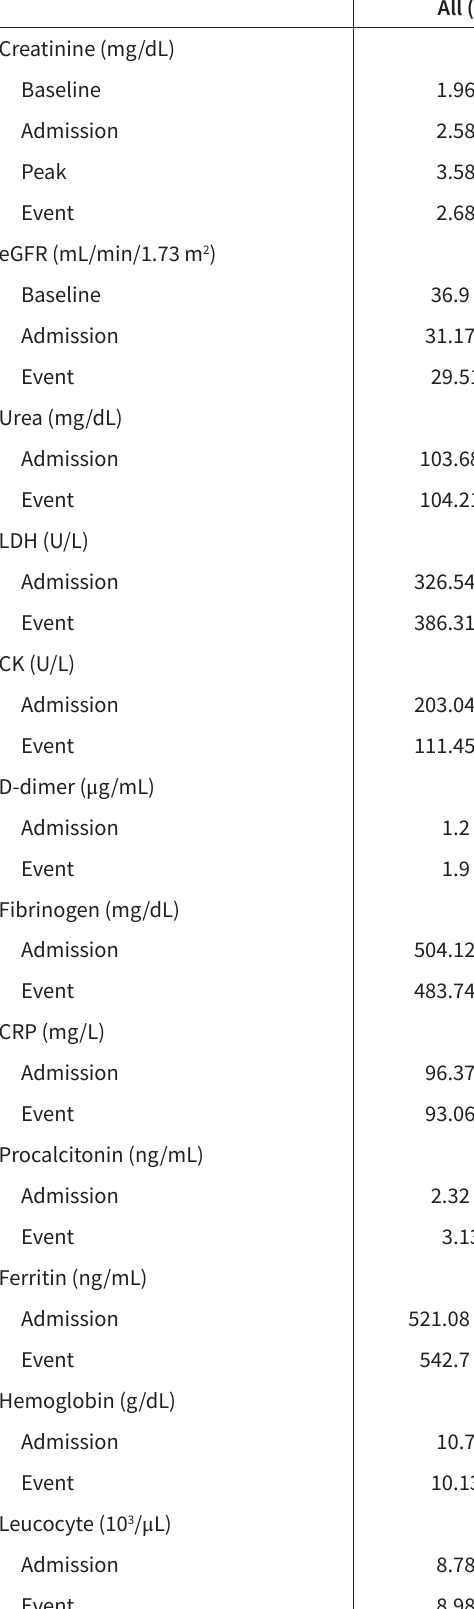
Table 2. Comparison of Patients’ Laboratory Findings Based on Mortality All (n = 71) Dead (n = 29) Discharged (n = 42)